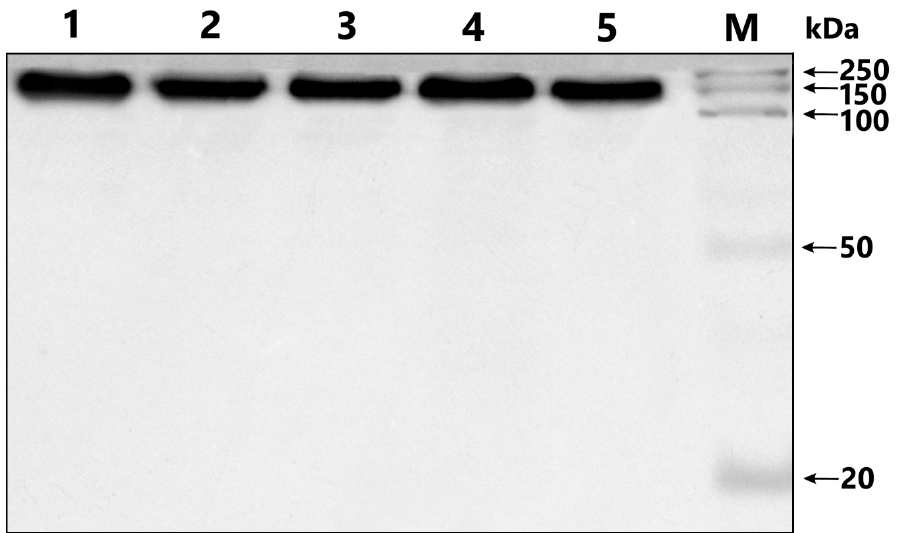
Figure 1. Analysis of homogeneity of IgG samples after SDS-PAGE in a 4–18% gradient gel and Coomassie G250 staining. Lanes 1–5: IgGs from different schizophrenia patients; M: protein molecular-weight markers.